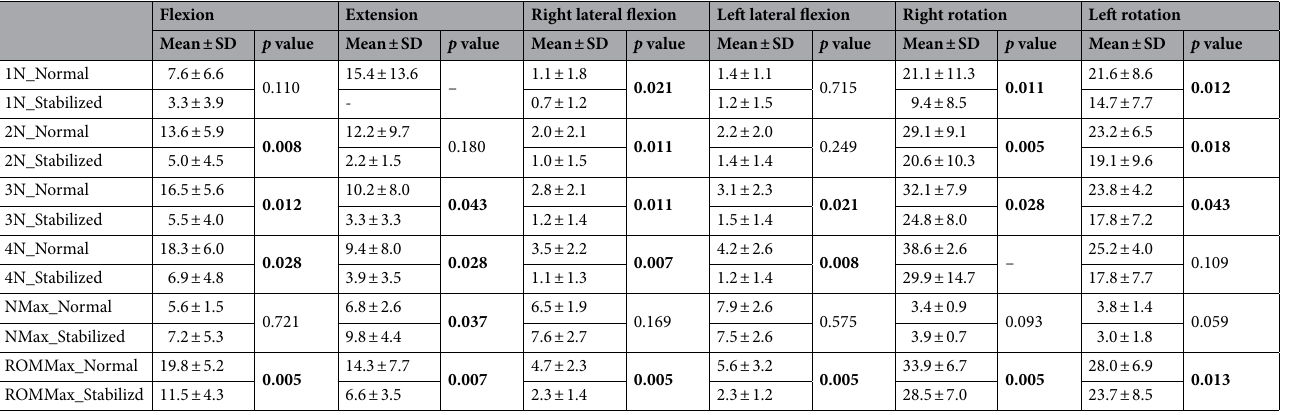
Table 5. Statistical significance of the maximal force applied and range of motion (degrees) at different standardized forces and end-range for normal and stabilized C0–C1 configurations in flexion, extension, right lateral flexion, left lateral flexion, right axial rotation, and left axial rotation. N: Newtons; F max: applied force at end range of motion; ROM max: end range of motion; SD: standard deviation. p values in bold showed statistical significance ( p <